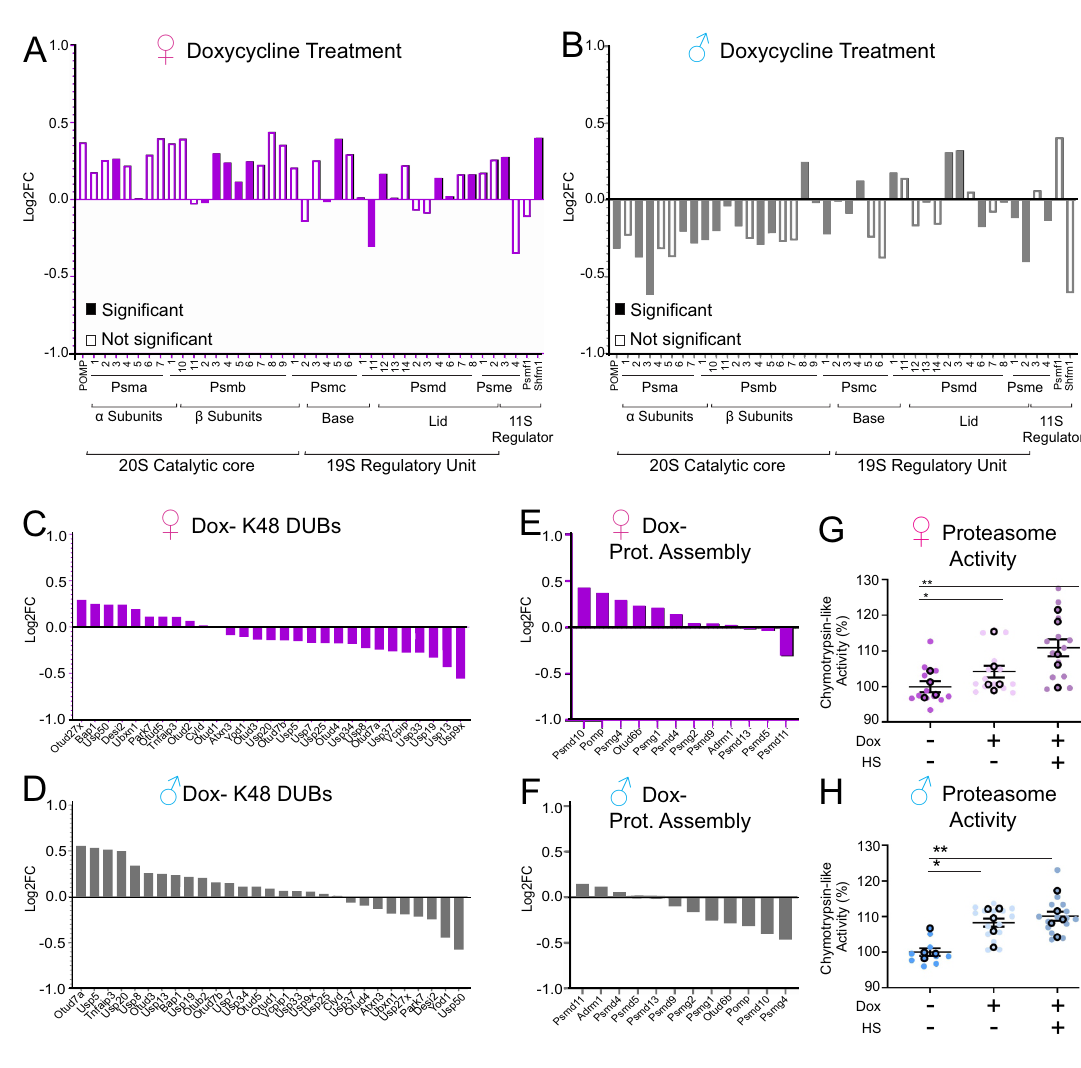
Figure 3. Doxycycline activates the transcription of proteasome genes in females. ( A , B ) Analysis of the relative expression of proteasome genes of the 20S, 19S and11S in the spinal cord of females (n = 4) (A) and males (n = 4) ( B ) following treatment with doxycycline. Significance is indicated if p < 0.05 by student’s t-test. ( C , D ) Analysis of the relative expression of deubiquitinating enzymes genes in the spinal cord of females (n = 4) ( C ) and males (n = 4) ( D ) following treatment with doxycycline. ( E – F ) Analysis of differential gene expression for proteasome assembly genes in the spinal cord of females (n = 4) ( E ) and males (n = 4) ( F ) following treatment with doxycycline. ( G , H ) Proteasome activity with and without doxycycline alone or with heat shock (HS) in the spinal cord of females (n = 4) ( G ) and males (n = 4) ( H ). * or **, indicates p < 0.05 or p < 0.005 by student’s